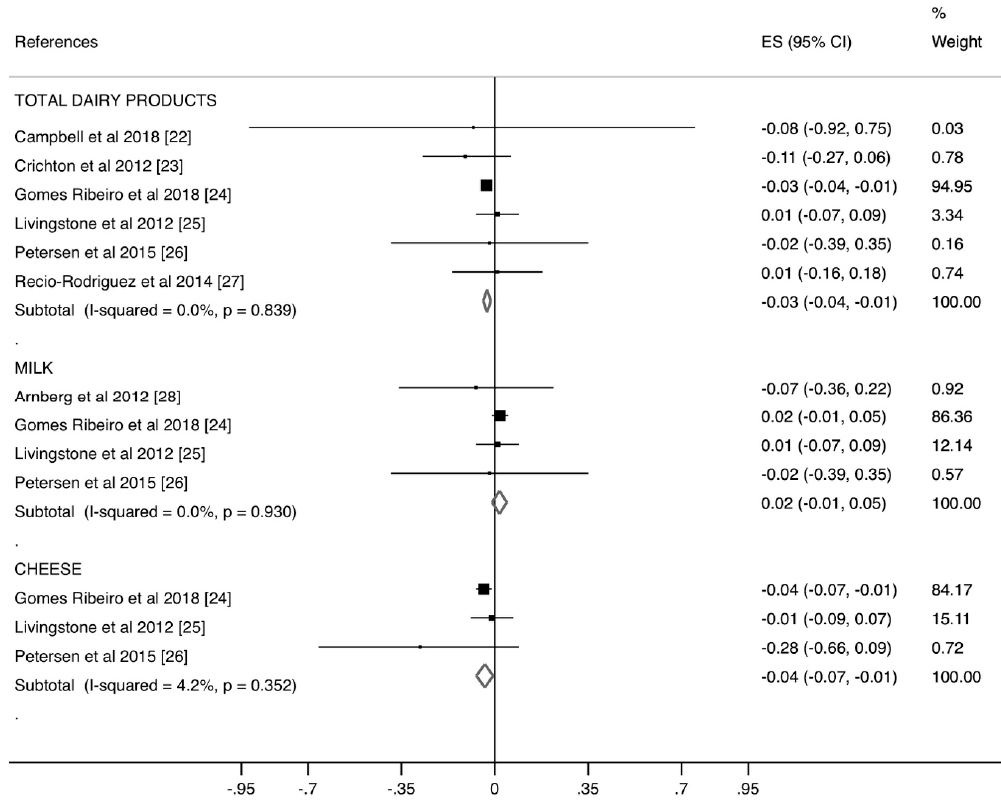
Figure 2. Forest plot of the estimated rate ratio of dairy products consumption and pulse wave velocity (PWV), by type of dairy product and